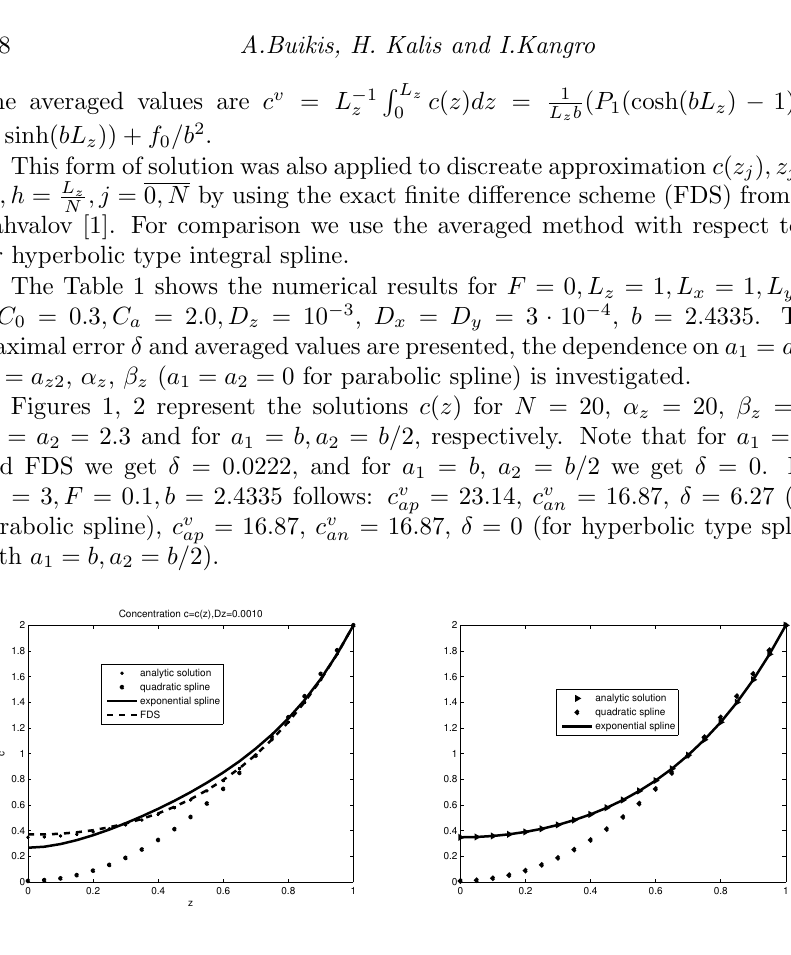
Figure 2. One layer solution c ( z ) for L z = 3 ,D 1 z = 10 e − 03 ,D 2 z = 10 e − 04 ,a 2 = a 1 /